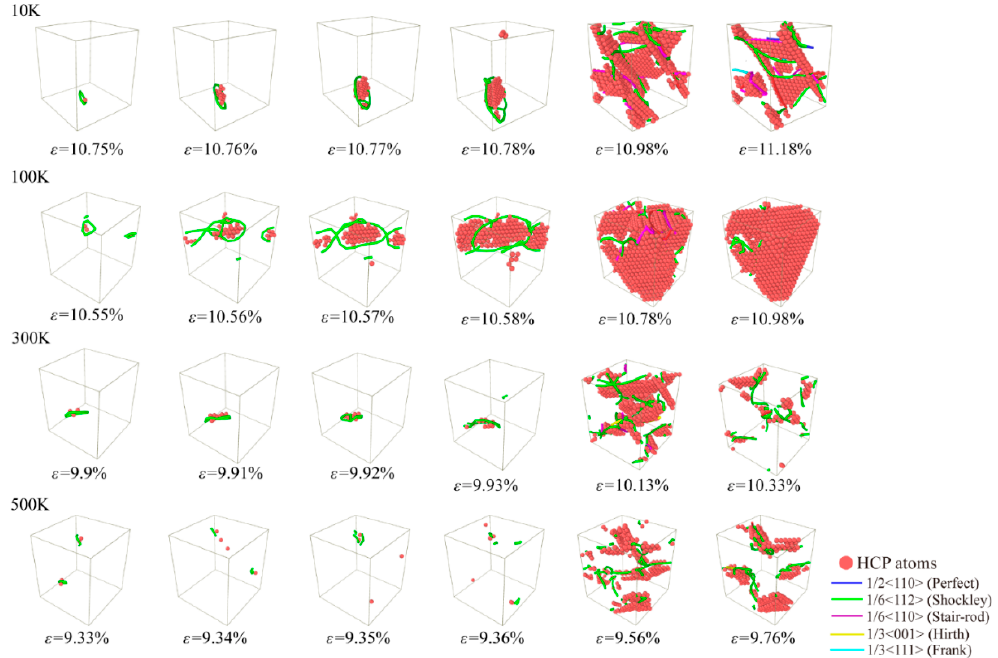
Figure 10. Atomic configuration snapshots of the systems under different tensile strains ε for Al-2%Mg alloy with background temperature span from 10 K to 500 K. The red atoms represent HCP atoms.